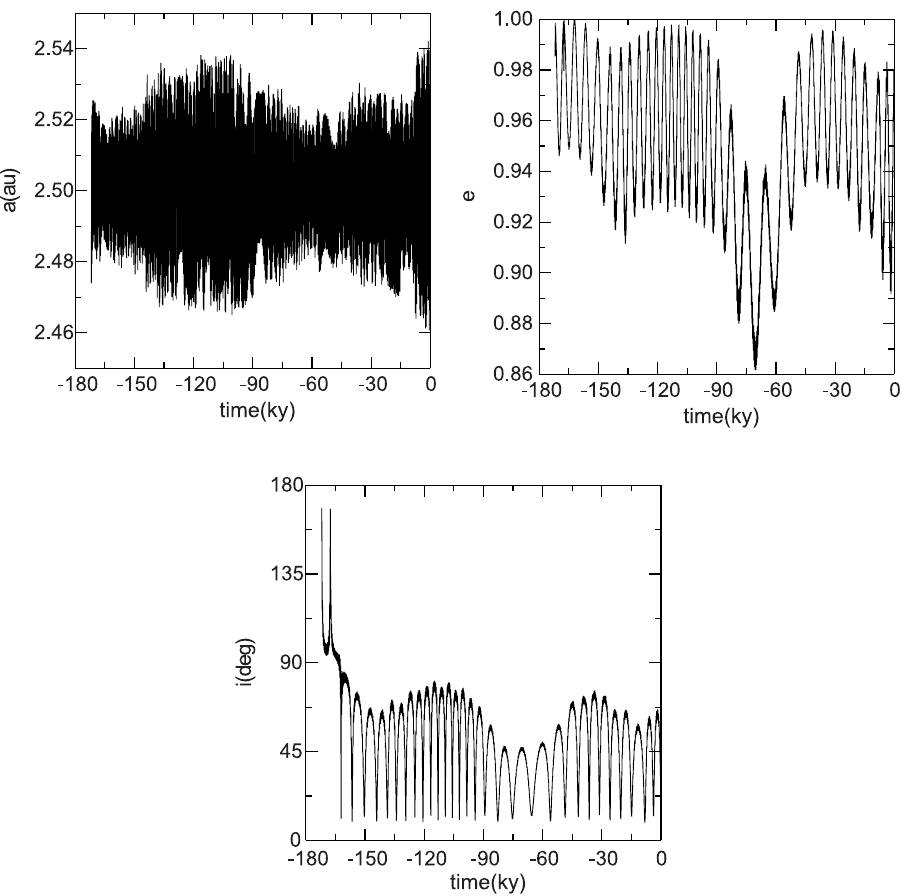
Figure 6: Backward orbital evolution of the comet 322P with the NG e ff ects.